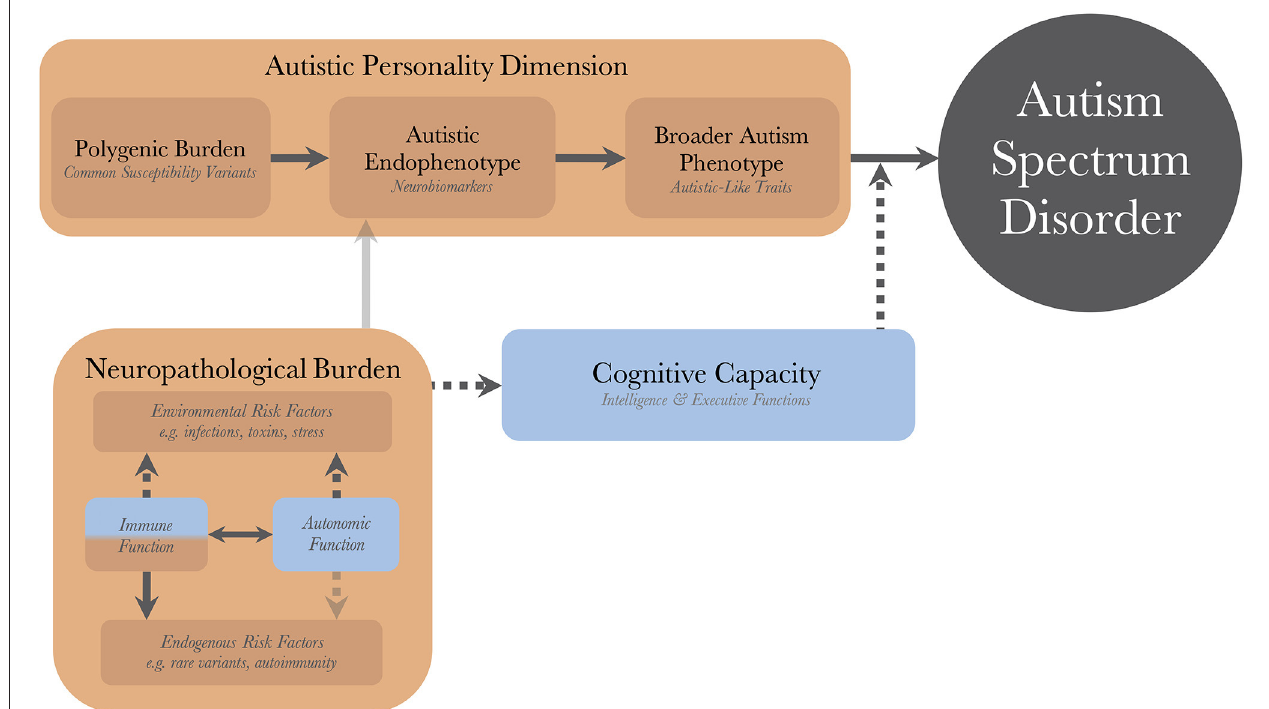
FIGURE 1 | The dynamics of the pathogenetic triad. Presentation of the pathogenetic triad outlining of the interactions between the operationalized factors. Red boxes indicate contributing mechanisms, having positive correlations with severity of clinical phenotype and probability of diagnosis, and blue boxes represent protective mechanisms. Full and dashed arrows indicate contributory and inhibitory mechanisms, respectively. The double arrow illustrates a bidirectional interaction with both contributory and inhibitory mechanisms. Transparent arrows indicate possible mechanisms for which research, with regard to autism, is lacking. There are also gene-environment interactions through other cognitive functions (than cognitive capacity), such as perception and personality, that bidirectionally affect the neuropathological burden, but these have been purposedly left out for model